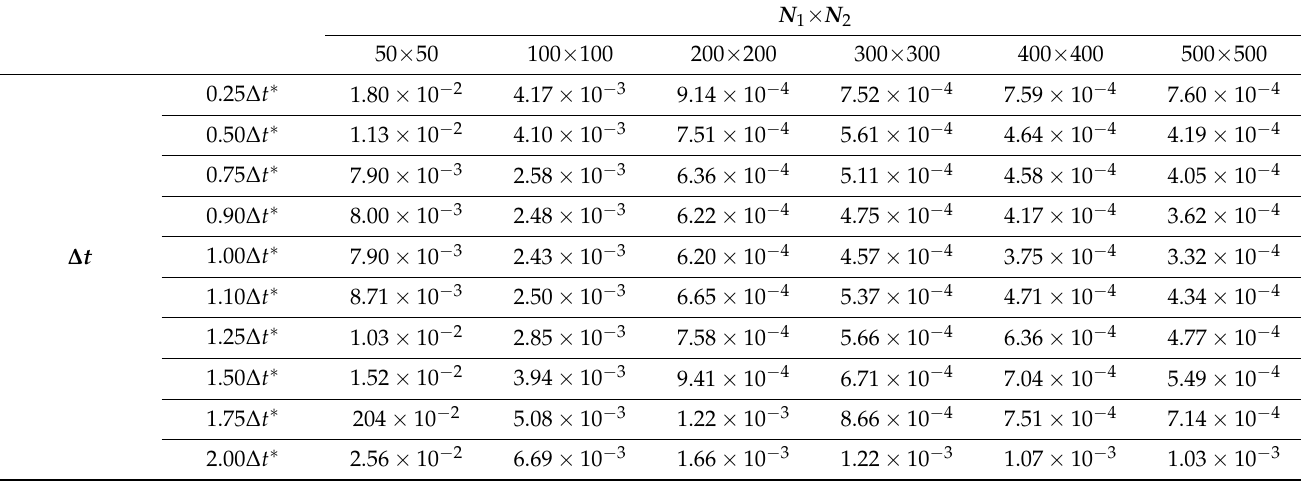
Table 1. The values of the first norm ( (cid:101) 1 ) for different time steps and mesh